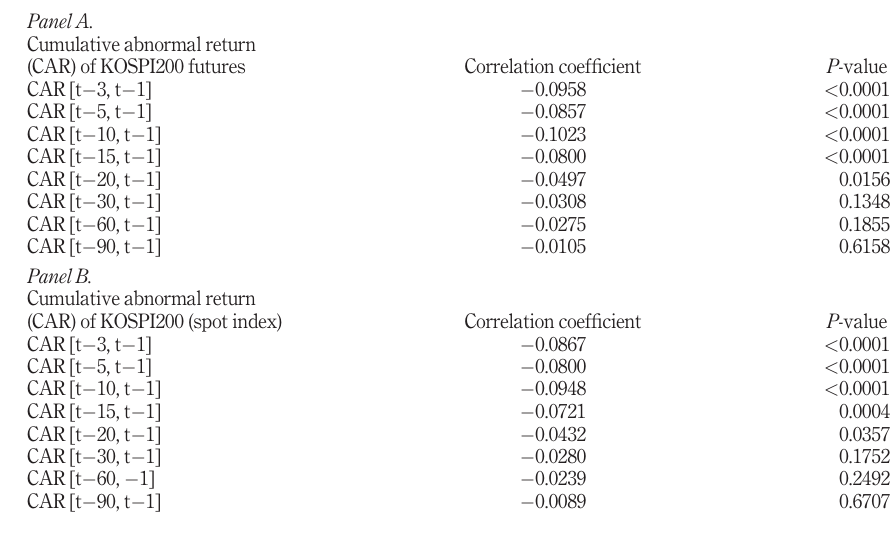
Table 2. Correlations with the NPS ’ s NIF in KOSPI200